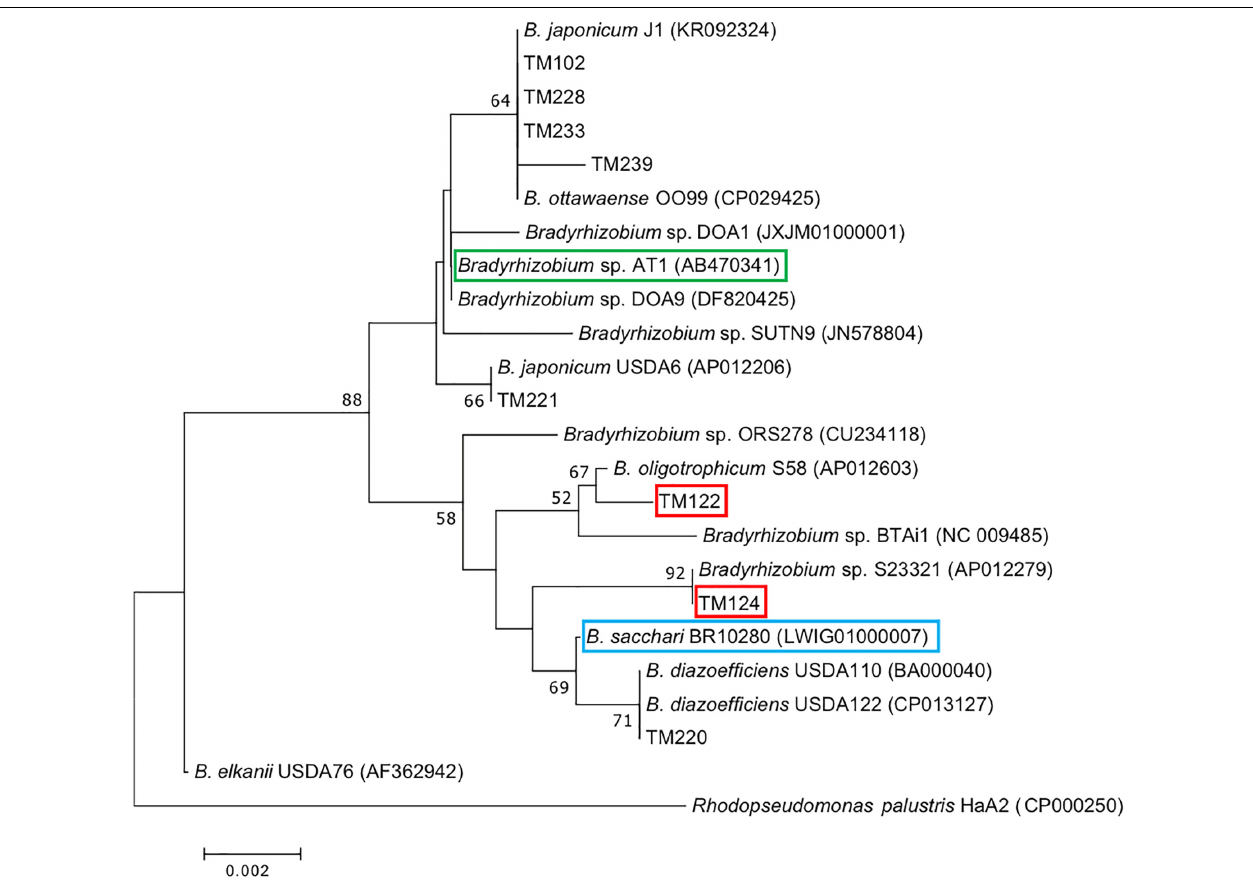
FIGURE 4 | Phylogenetic tree of 16S rRNA genes of bradyrhizobial isolates from sorghum roots (prefix TM) constructed by the neighbor-joining method. Numbers at the nodes are percentages of 1000 bootstrap replications supporting the partition. Red boxes indicate functional diazotrophs suggested by our omics analysis derived from sorghum roots (TM122, TM124), while blue and green boxes indicate diazotrophic bradyrhizobia from sugarcane (BR10280) and sweet potato (AT1),